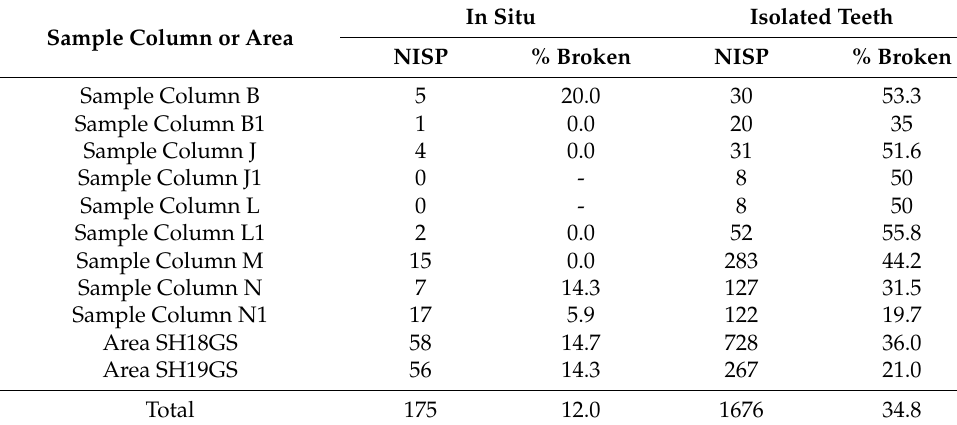
Table 4. Number of teeth examined in each sample column or